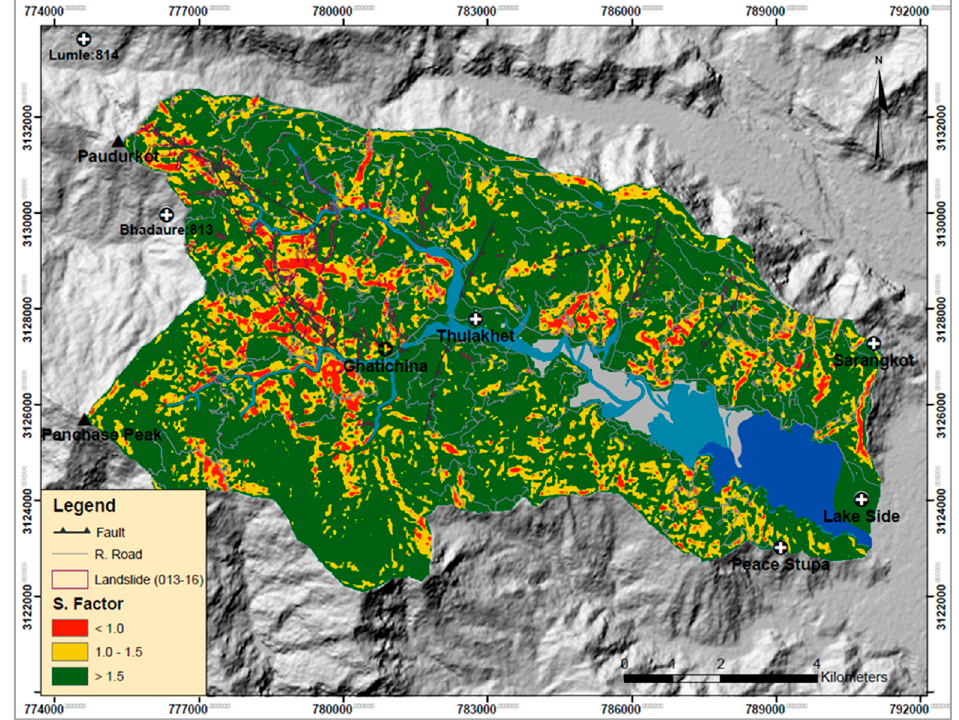
Figure 5. Landslide susceptibility model (LSM) of Phewa Lake watershed (scenario 1) indicting the rural roads, fault line, and landslide inventory of 2013–2016.